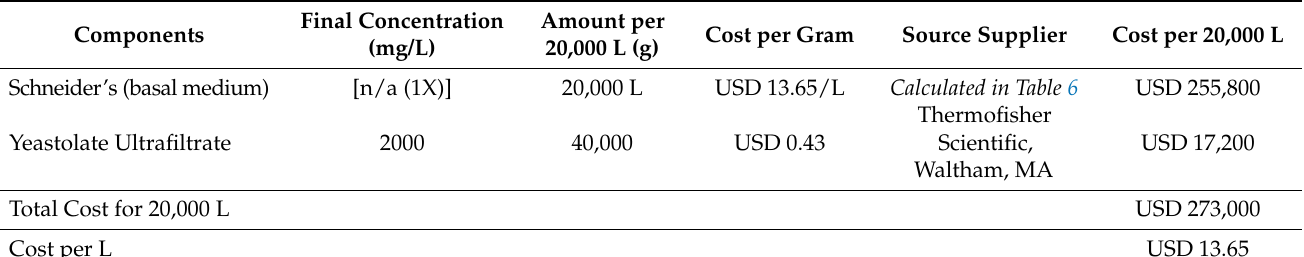
Table A7. Cost of Schneider’s medium components and their relative cost contribution to hypothetical 20,000 L batch in